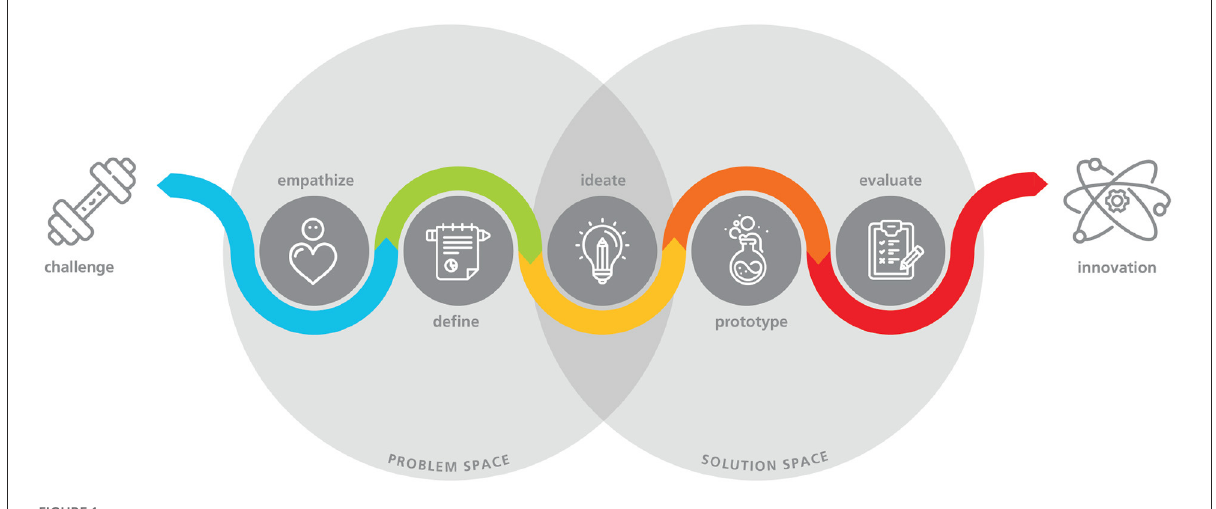
FIGURE1 Design thinking process by Fraunhofer FIT (FIT,